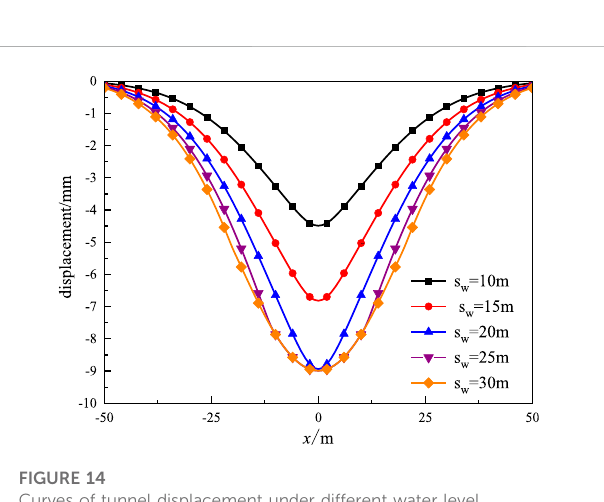
FIGURE 12 Curves of water level under different water level drawdown s w.